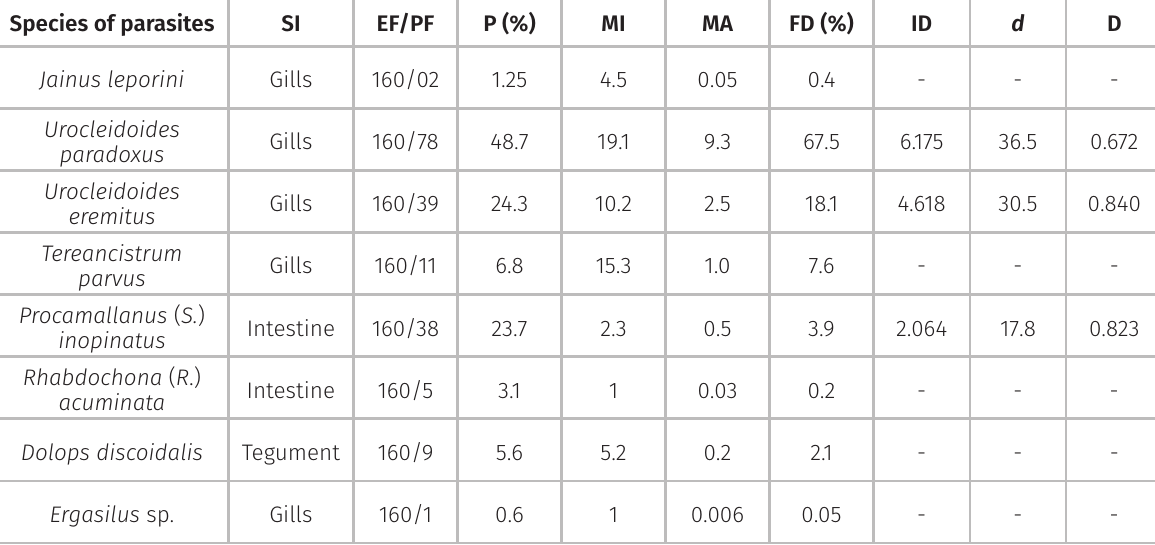
Table IV. Parasites in Leporinus macrocephalus (N= 160) of fish farms from the Rio Branco, in State of Acre, western Amazon region